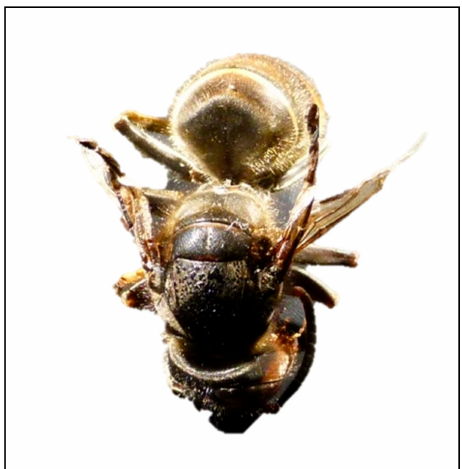
Figure 1. Dorsal view of deformed wings in hornet (sample 159 + naturally curled up by